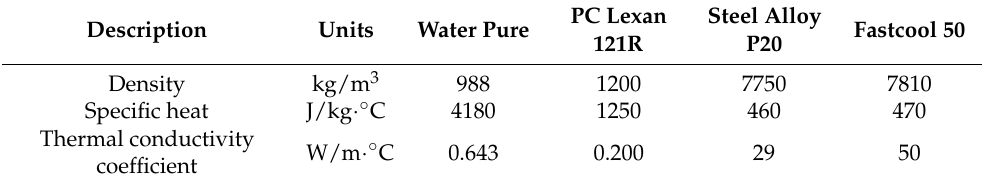
Figure 11. Materials and boundary conditions defined for the new conformal cooling triple hook— shaped and Fastcool insert configuration. Table 4. Magnitude of the physical properties of the defined materials.